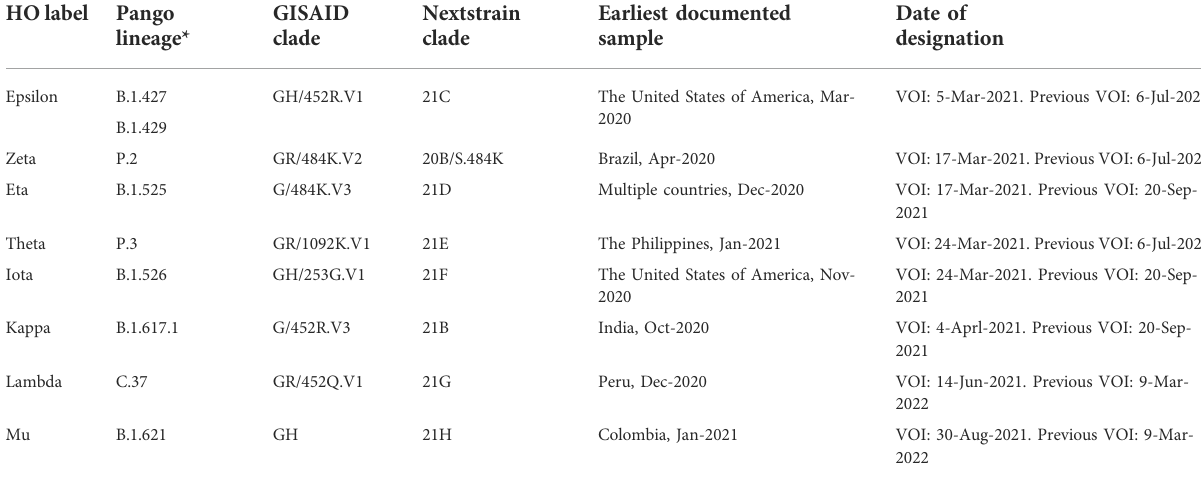
TABLE1VariantsofinterestofSARS-CoV-2(adoptedfromtheWorldHealthOrganization,2022availableathttps://www.who.int/activities/tracking- SARS-CoV-2-variants (accessed on 21 July 2022)). HO